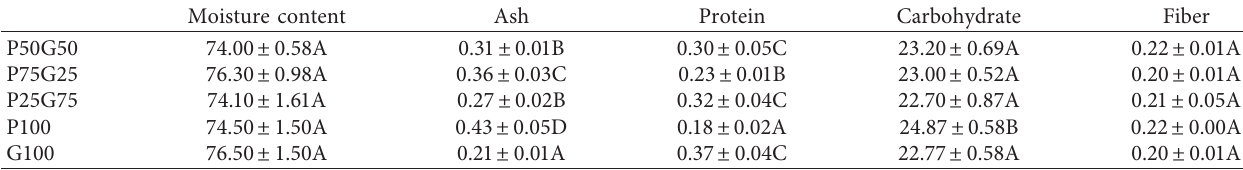
Table 1: The effects of pectin: gum ratio on the moisture, ash, protein, carbohydrate, and fiber content of samples. Moisture content